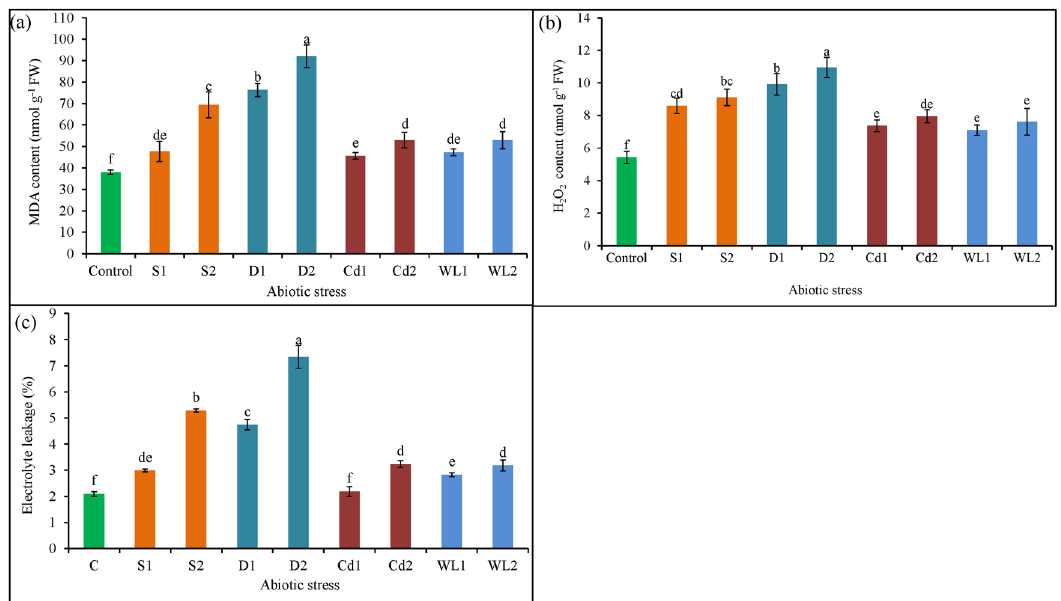
Figure 5: MDA ( a ) , H 2 O 2 ( b ) , and EL ( c ) contents of C. olitorius plants a ff ected by di ff erent abiotic stresses. S 1 , S 2 , D 1 , D 2 , Cd 1 , Cd 2 , WL 1 , and WL 2 represent 200 mM of NaCl, 400 mM of NaCl, 10 days of water de fi cit, 15 days of water de fi cit, 2 mM of CdCl 2 , 4 mM of CdCl 2 , 5 days of waterlogging, and 15 days of waterlogging, respectively. Mean value (± SD ) was calculated from three replicates for each treatment. Values in a column with di ff erent letters are signi fi cantly di ff erent at p ≤ 0.05 applying LSD